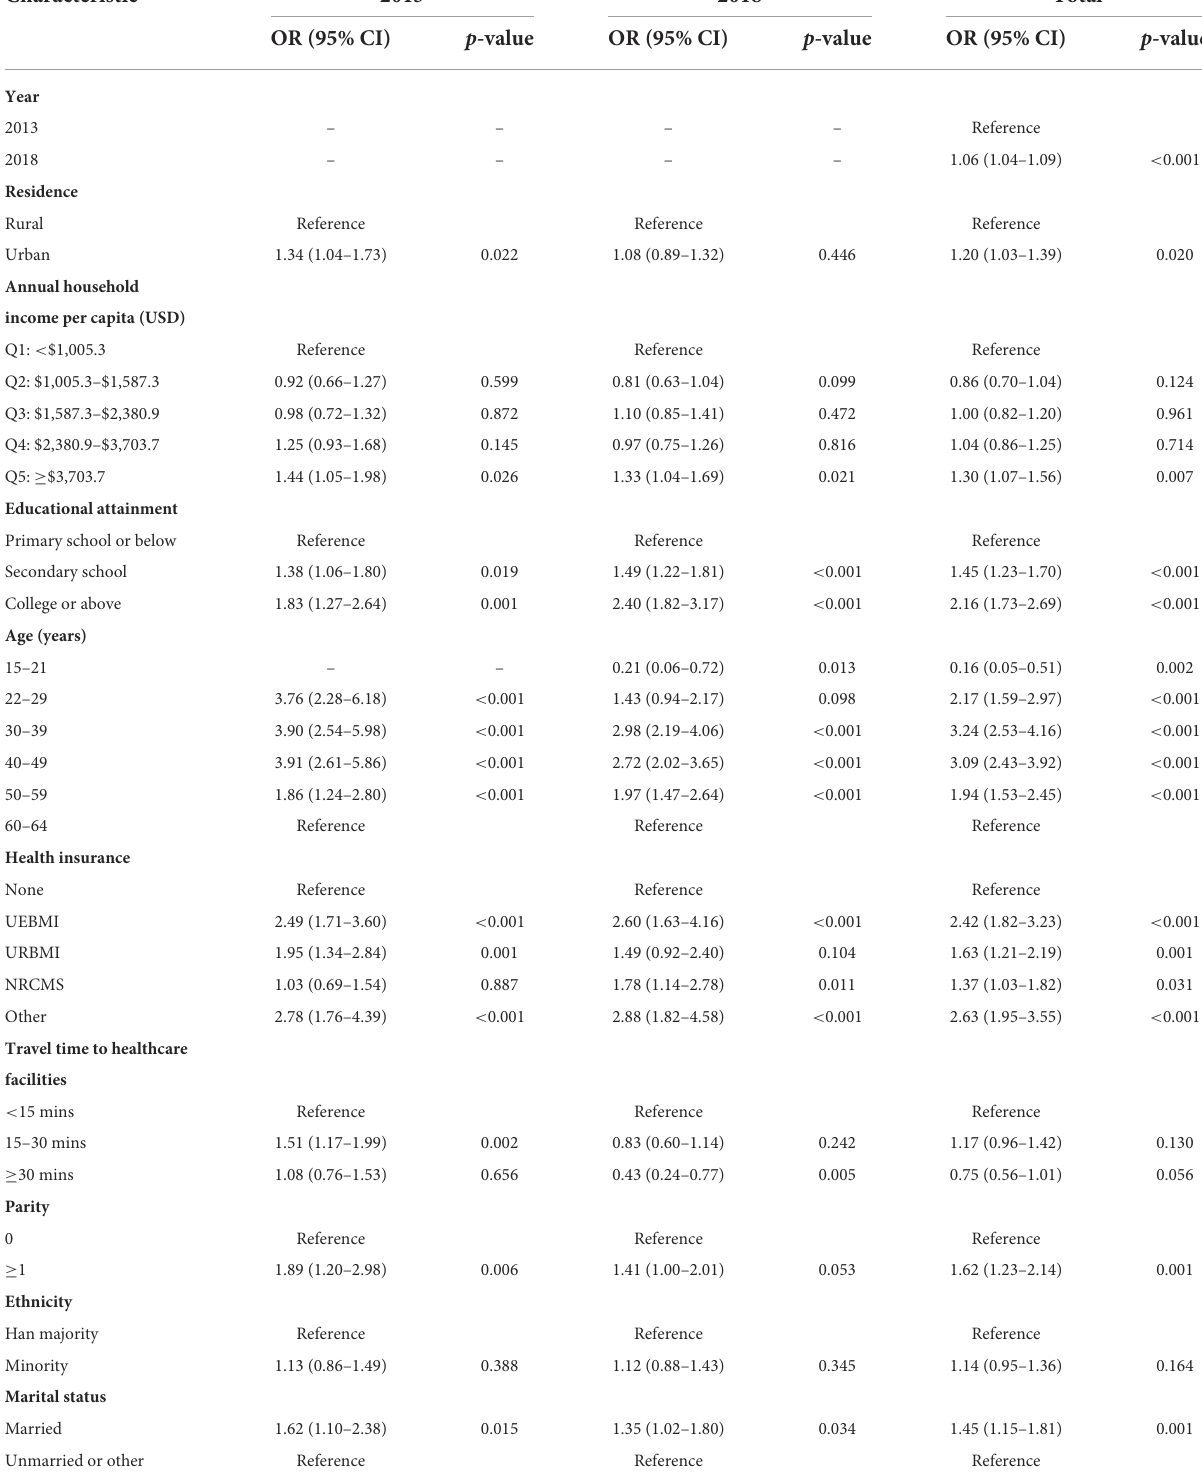
TABLE 2 Odds ratios, 95% confidence intervals, and p values obtained from multivariate logistic regression of the use of cervical cancer screening on the socioeconomic and other factors for 2013 and 2018 in China.